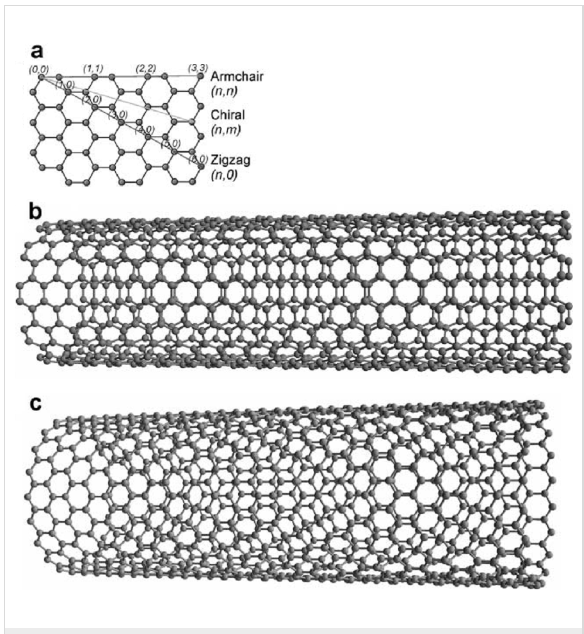
Figure 1: (a) The wrapping vector of a graphene sheet defines the structure (chirality) of a carbon nanotube. Examples of (b) ‘‘armchair’’ and (c)‘‘zig-zag’’ SWCNTs. [1]. – Reproduced by permission of The Royal Society of